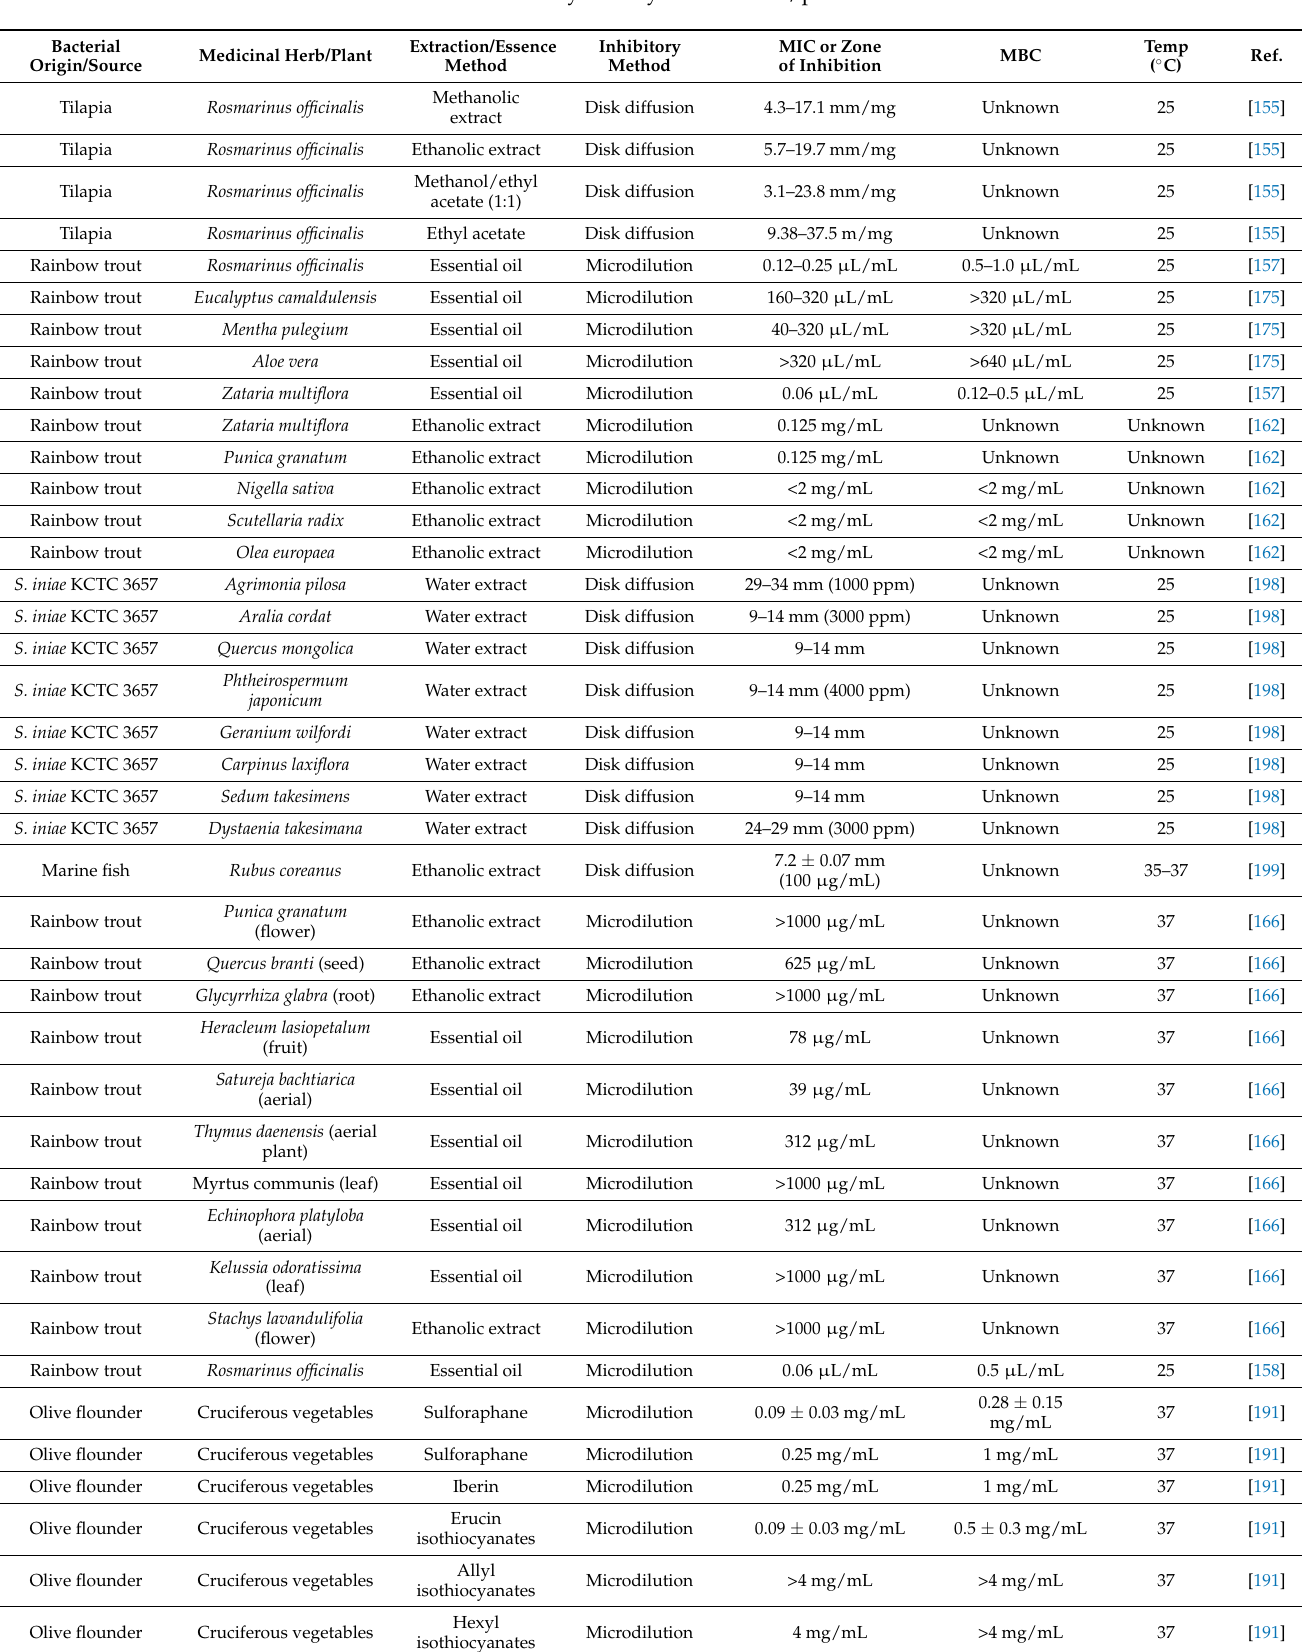
Table 1. In vitro inhibitory activity of medicinal/plants to S.